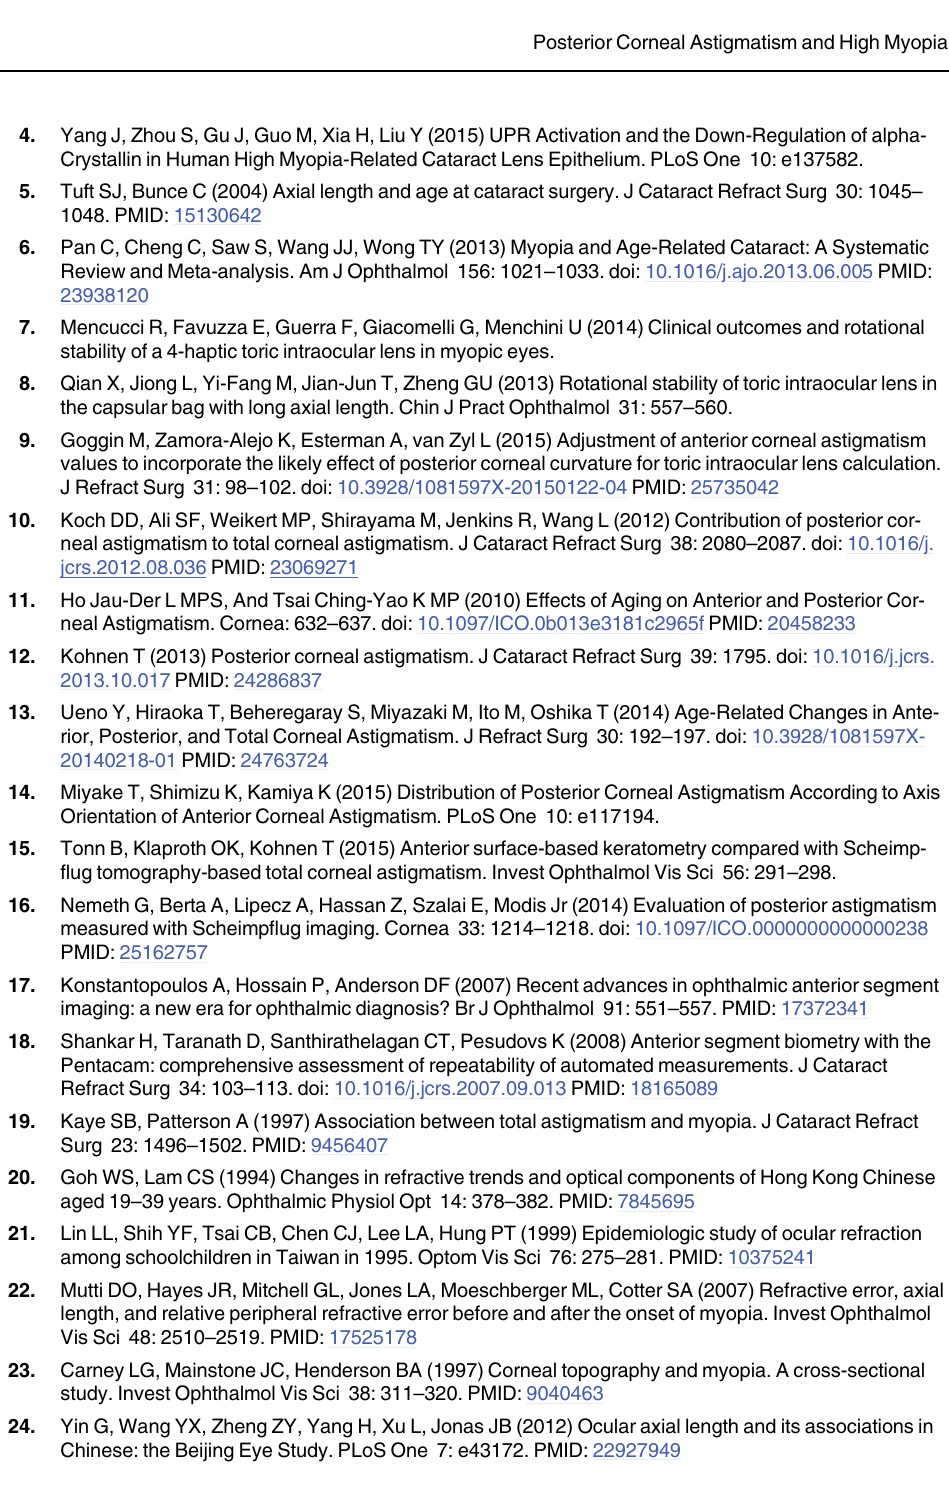
PLOS ONE | DOI:10.1371/journal.pone.0162012 September 7,